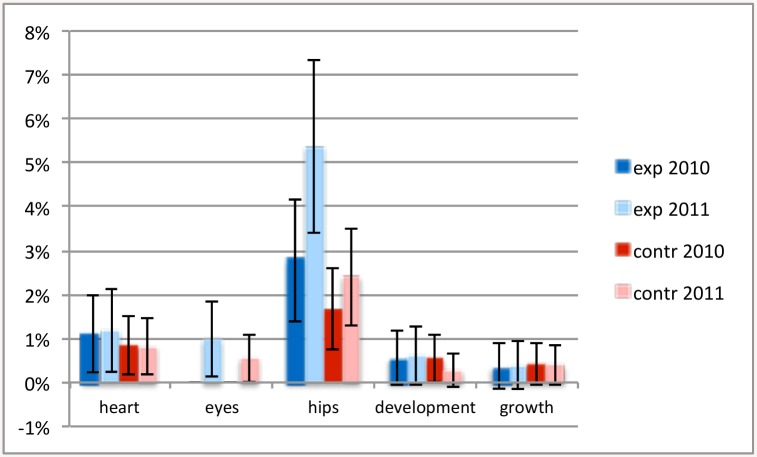
Percentage of children referred with abnormal findings.A comparison is shown between abnormal findings of heart, eyes, hips and growth, in experiment and control region, before and during the experiment. The black error bars indicate the 95% confidence intervals.